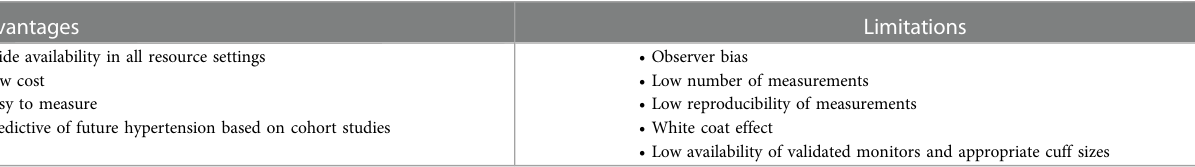
TABLE 1 Advantages and limitations of of fi ce blood pressure.